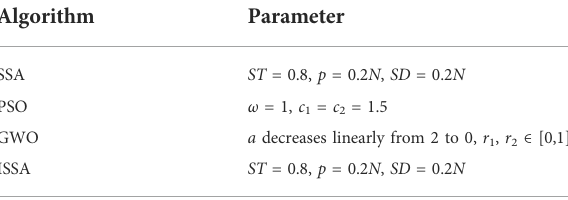
TABLE 1 Experimental parameters for four optimization algorithms.